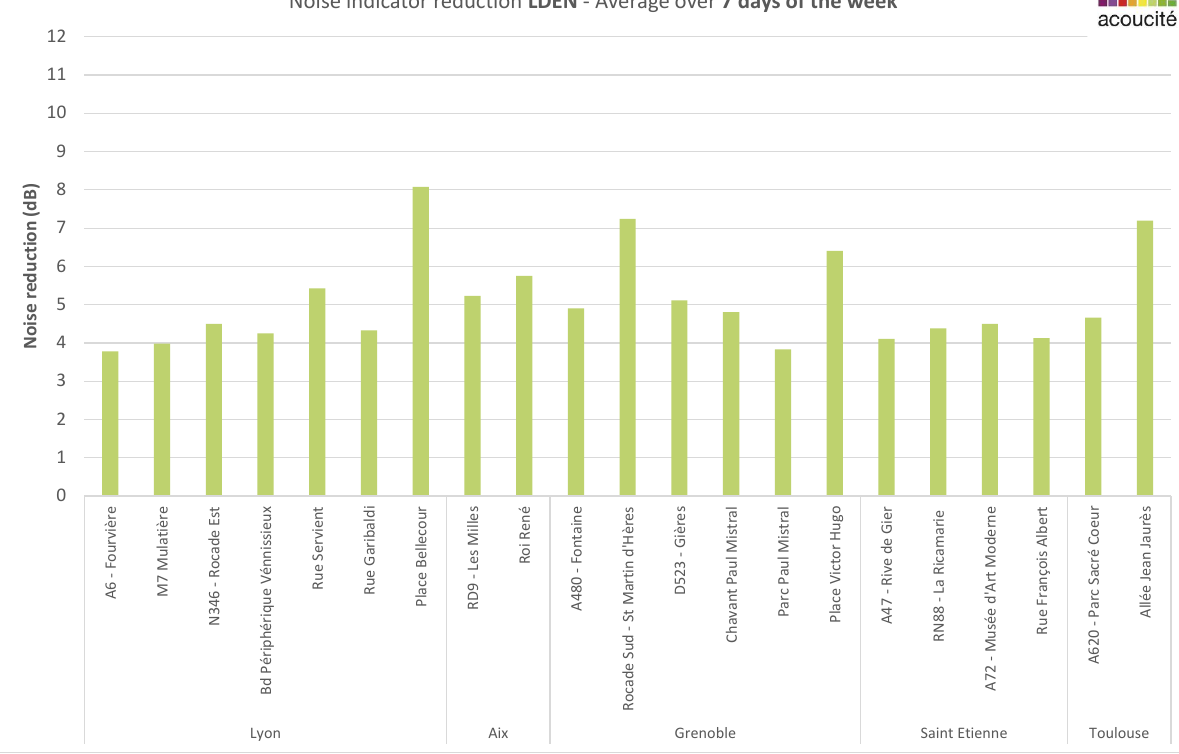
Figure 3: Reduction observed on the LDEN indicator for the 21 measuring stations. Difference between the average sound level in “normal situation” and the average sound level during